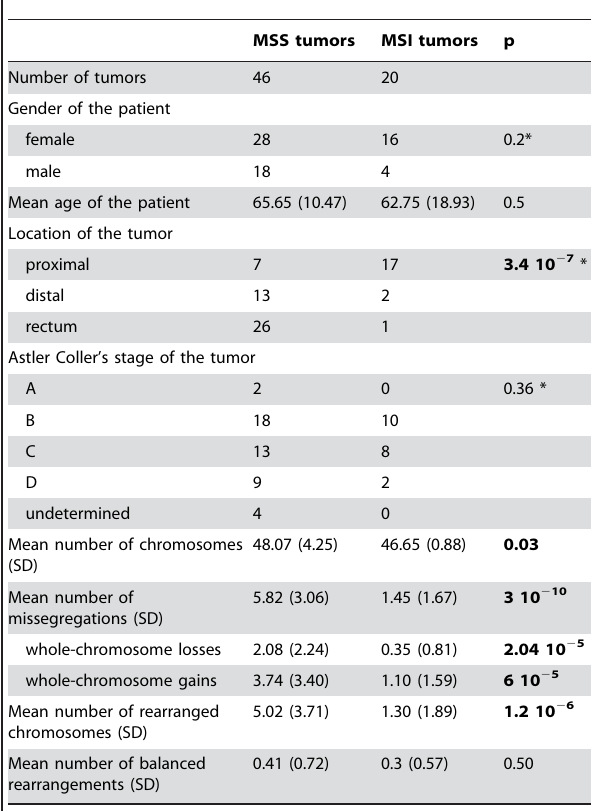
Table 1. Comparison of MSI and MSS tumors: clinicopathological characteristics and frequency of chromosome